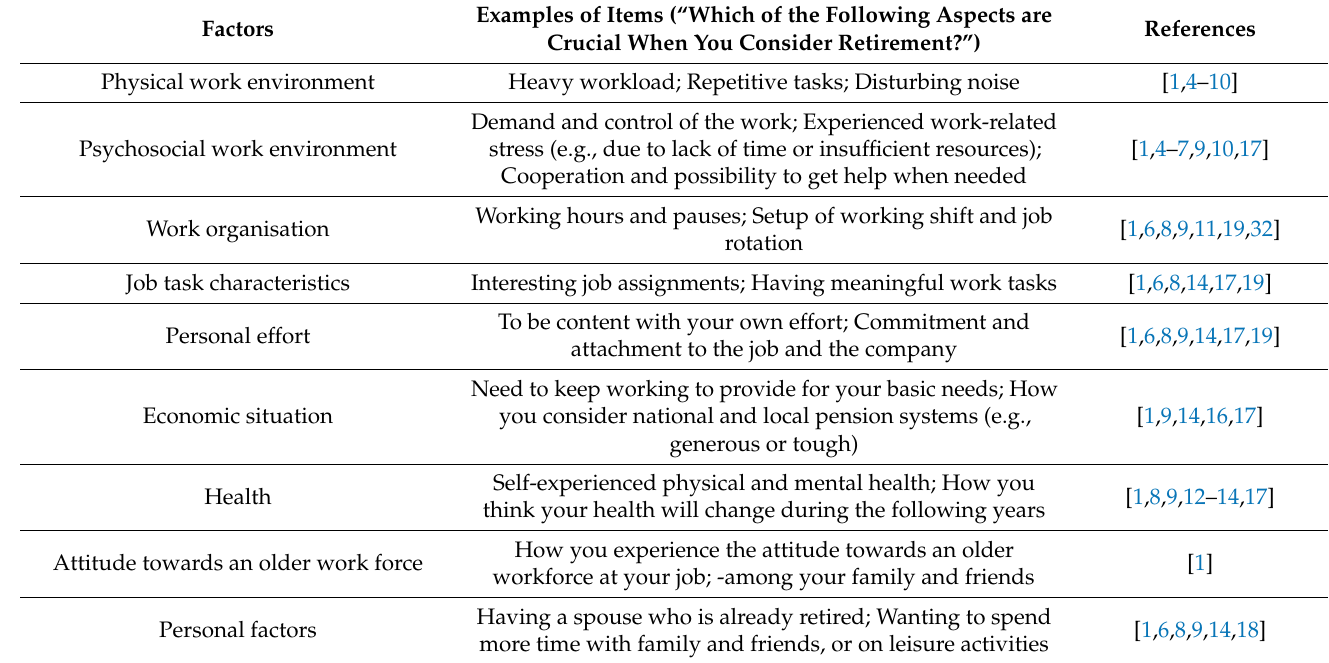
Table 3. Factors and examples of items included in the